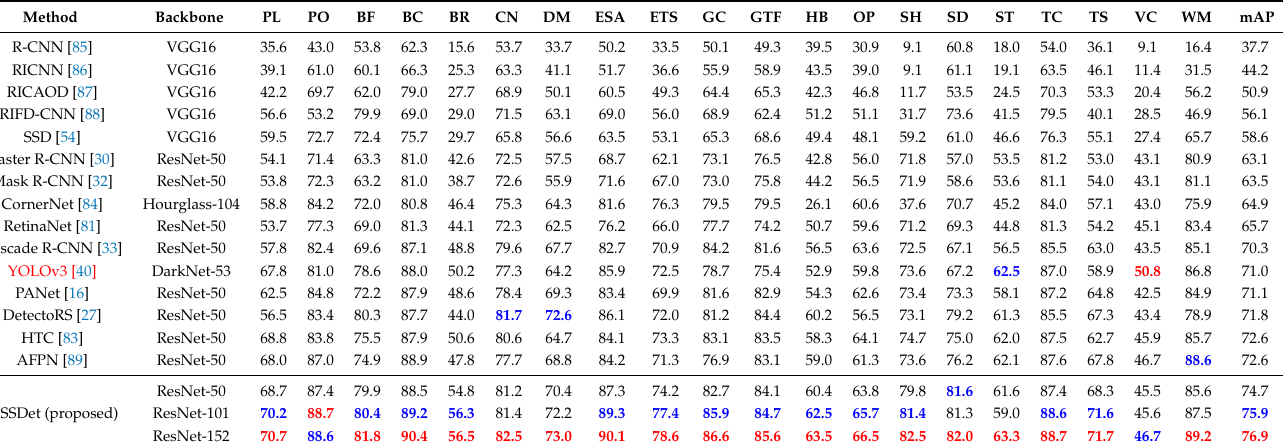
Table 7. Evaluation of generalizability of MSSDet on DIOR dataset. Results colored red or blue indicate best or second-best result, respectively, of each